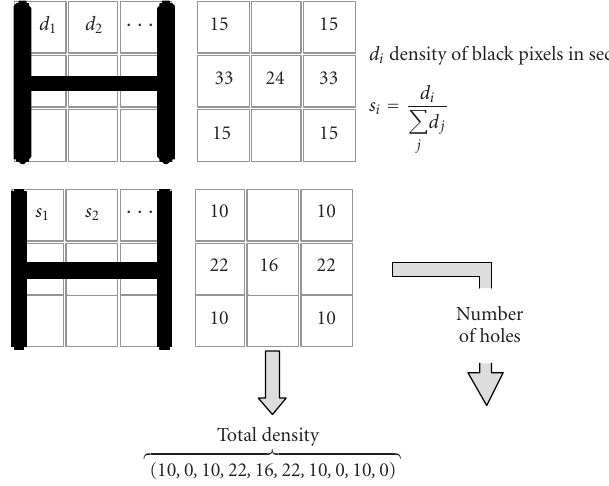
Figure 3: Vector representation including number of holes and total density.